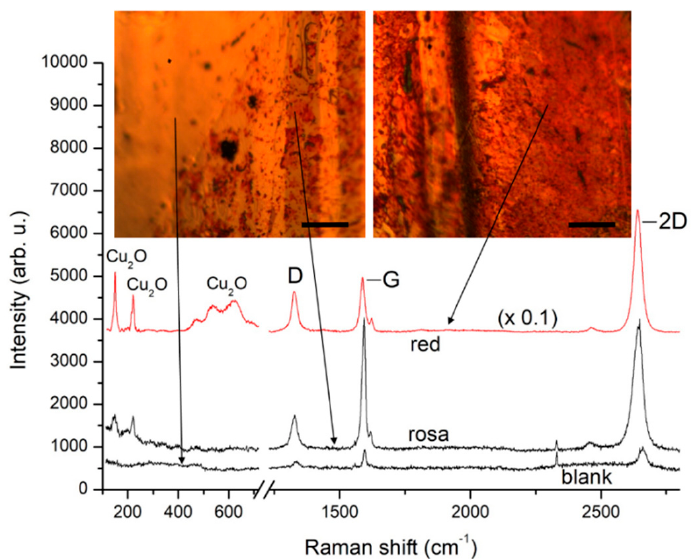
Figure 1. Micro-Raman spectra from different regions of a Gr/Cu foil several months after the CVD graphene growth process. The traces are plotted after background subtraction for clarity. Insets: microscopic images from the corresponding regions with exact specification of the spots of laser excitation. The scale bars represent 100 μ m.